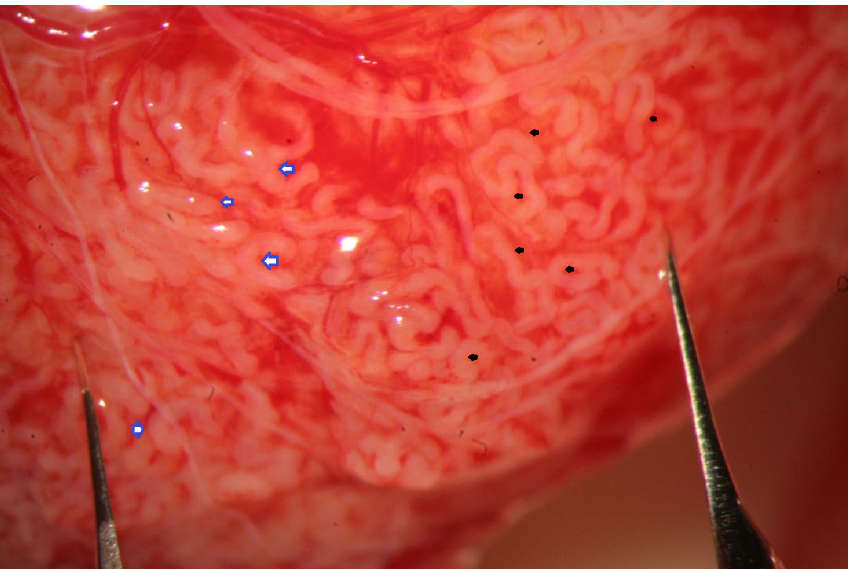
Figure 3. High magnification (×24- > ×36) allows the easy discrimination between seminiferous tubules of different sizes (those marked by blue arrows are very slightly larger than those marked by black arrows).